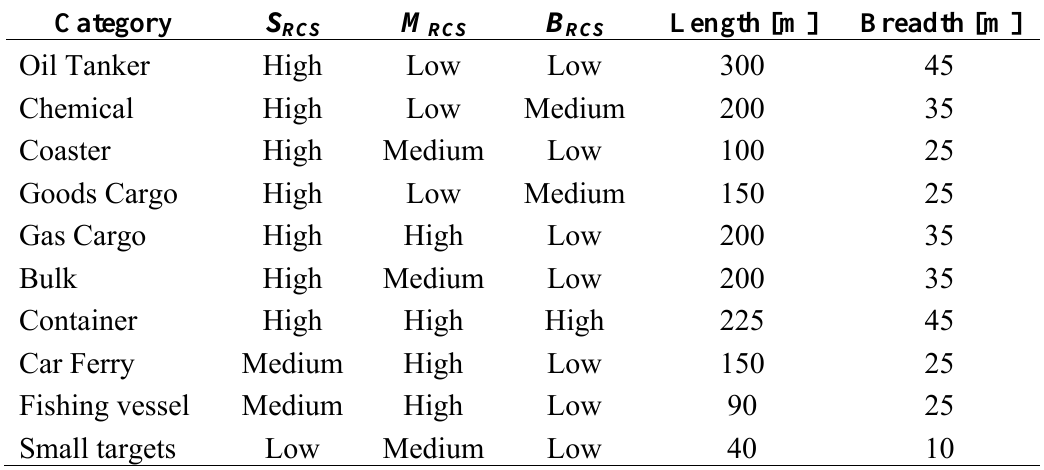
Table 1 . Reference categories with the grades expected for the three normalized RCS